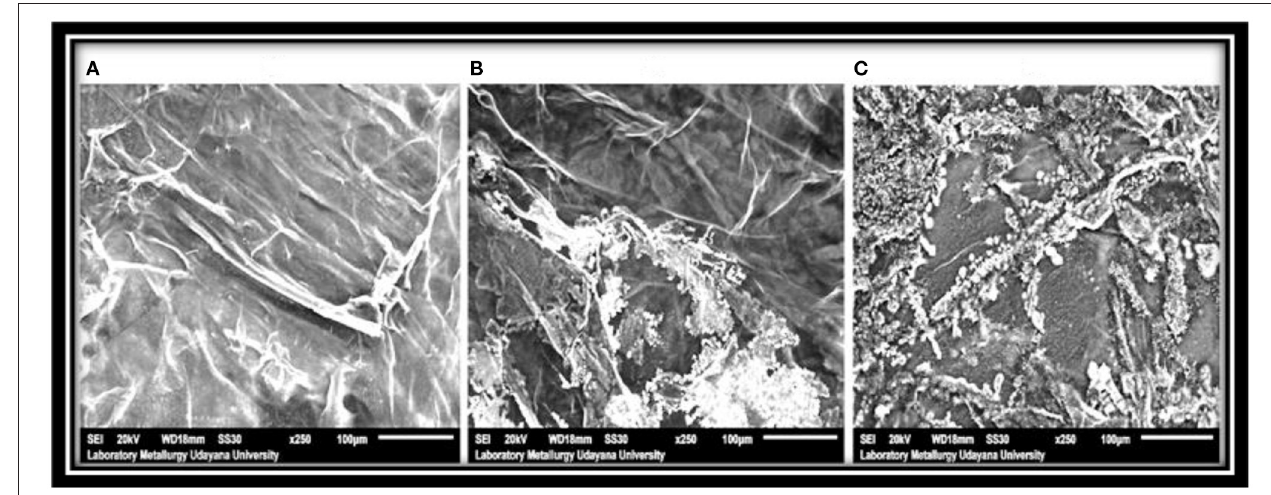
Frontiers in Sustainable Food Systems |